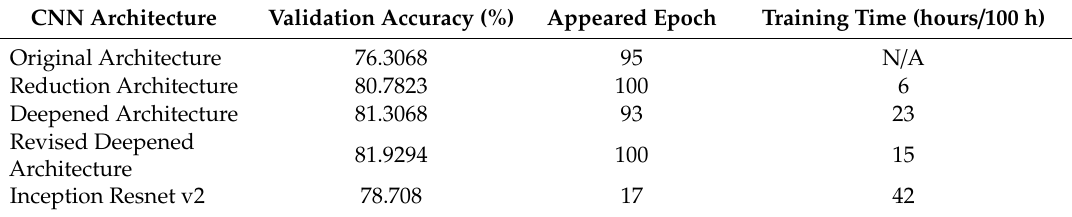
Figure 8. Validation accuracies of five different CNNs. ‘Org’ represents original feedforward CNN; ‘Ext2’ represents revised deepened CNN; ‘Ext1’ represents deepened CNN; ‘Rdu’ represents reductive CNN; ‘Inc’ represents Inception Resnet v2. Table 6. Comparison of highest validation accuracy of different CNNs.